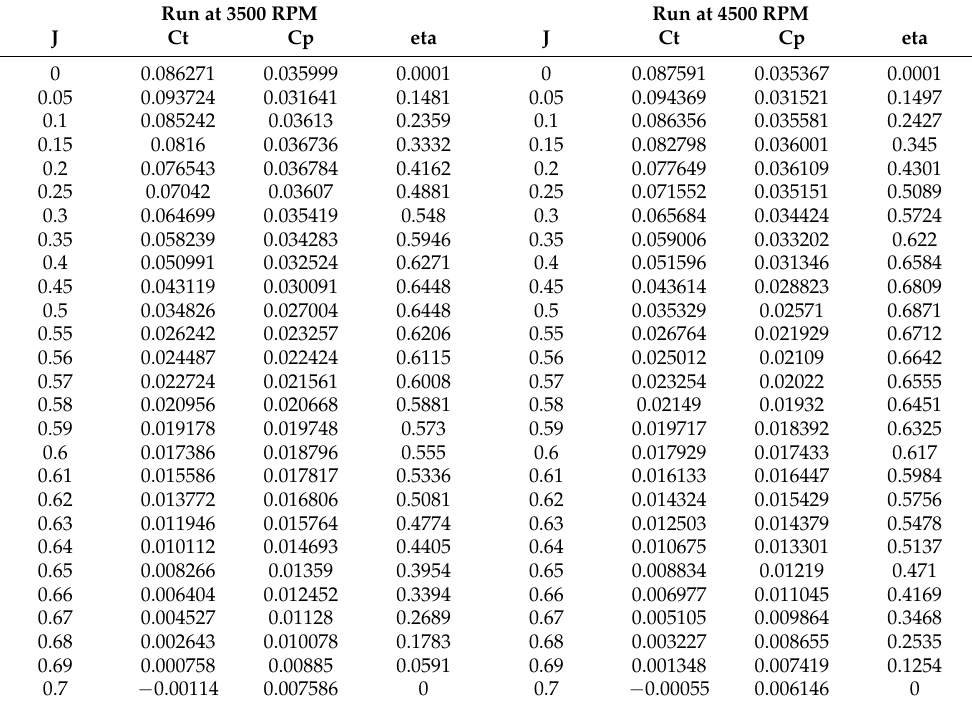
Table A23. BEMT 18 × 10 APC propeller data.